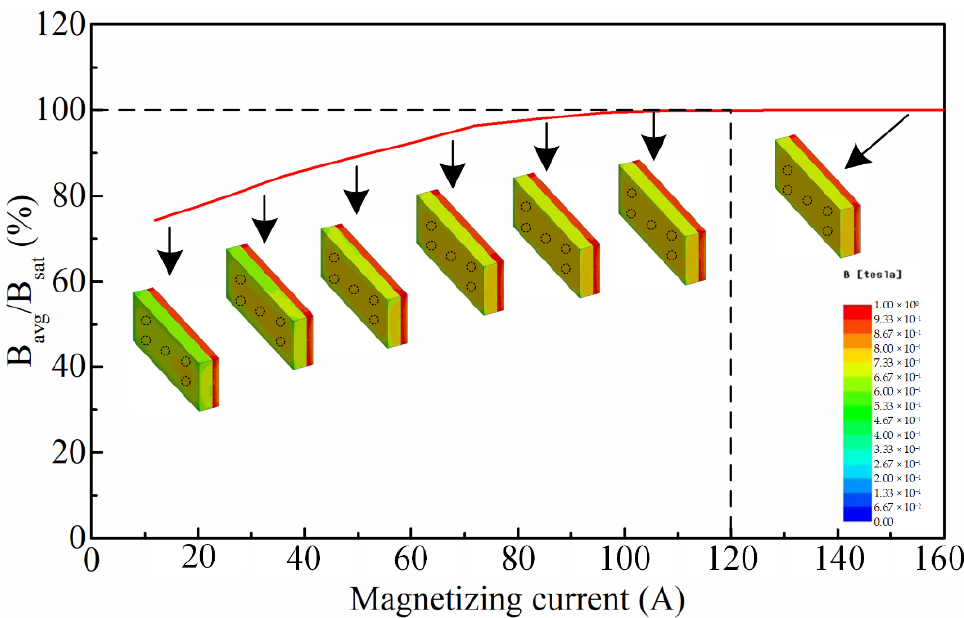
Figure 7. Average resultant magnetic flux density (normalized) on the sample points of the LCF PM after different magnetizing currents.